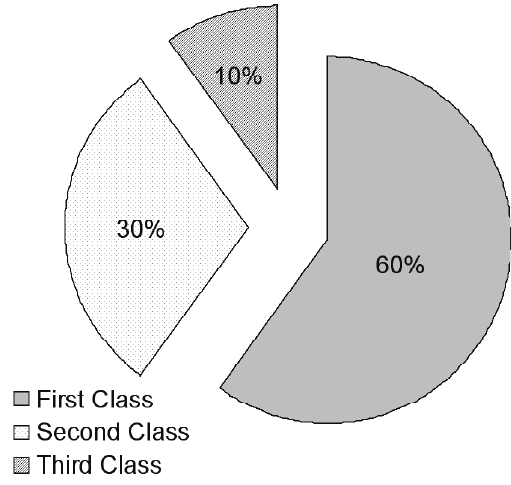
Figure 2: Distribution of respondent contractors by their